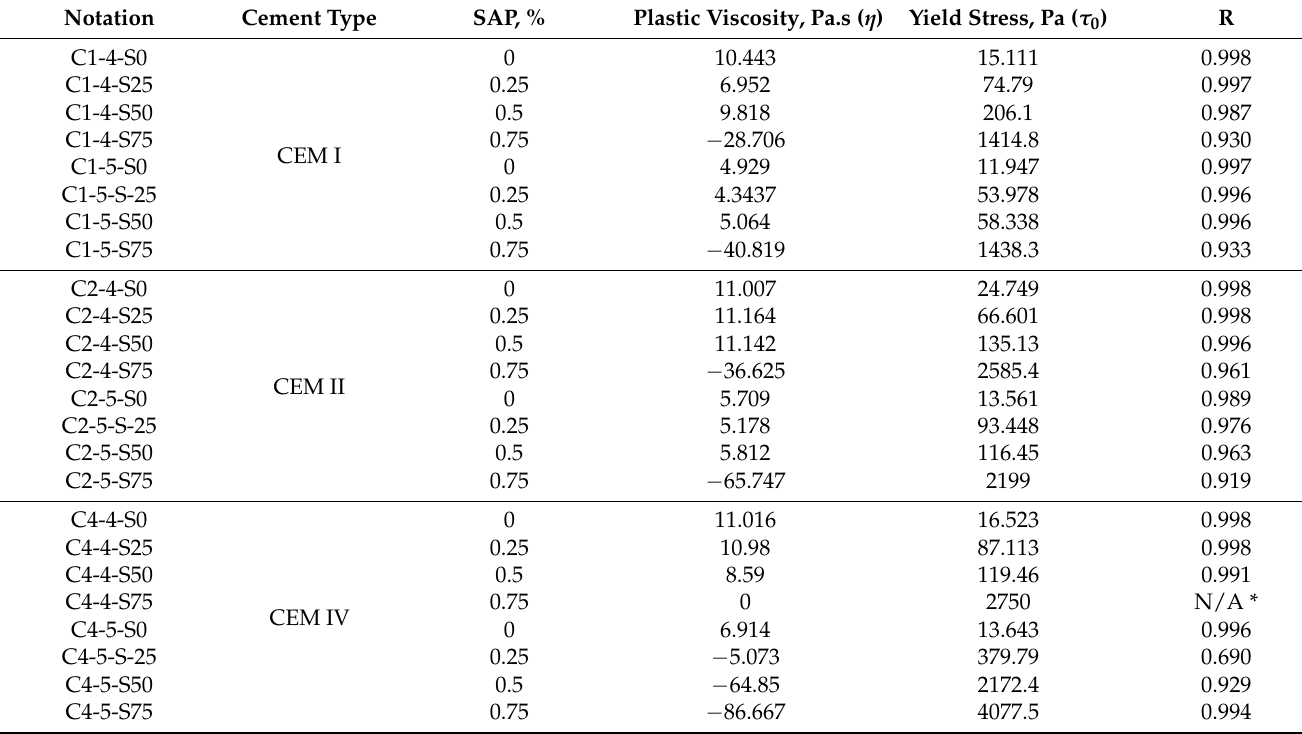
Figure 9. Yield stress values of SAPCPs, including di ff erent cement types and SAP contents.